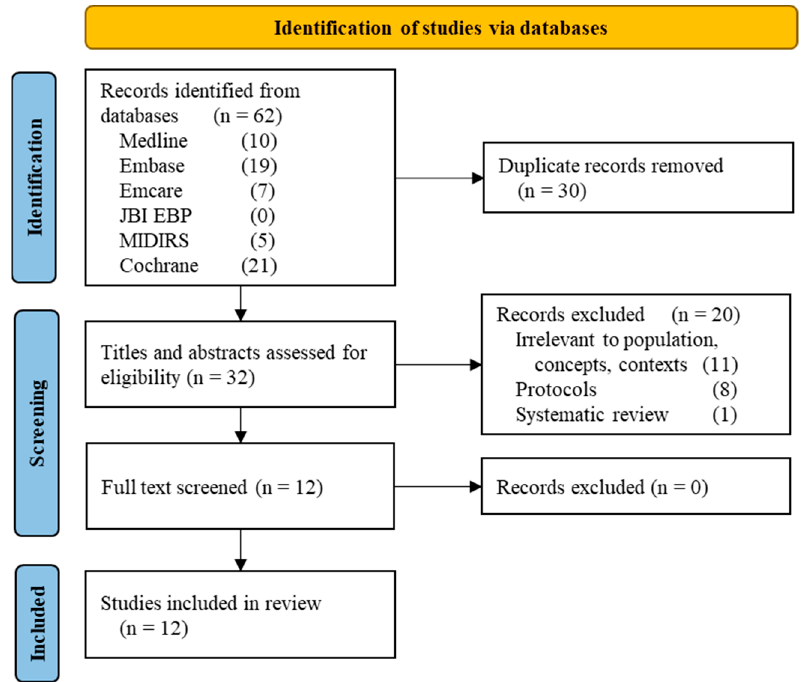
Figure 1. Study flow chart.